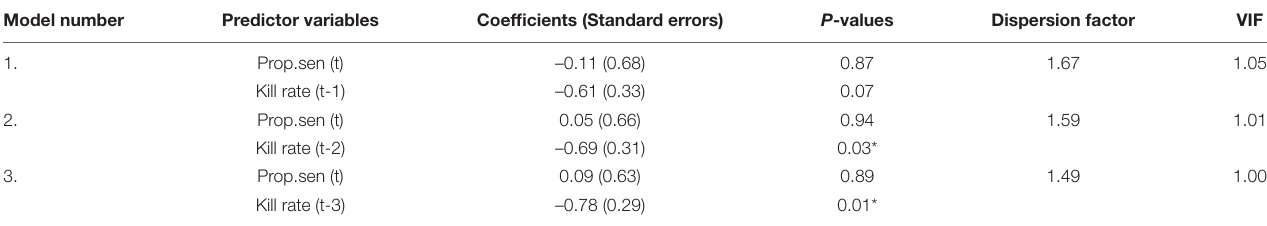
TABLE 1 | Coefficients from bivariate models predicting temporal variation in the incidence of OA among dead moose over a 33-year period (1975–2007) from the proportion of adults in the populations that were senescent (Prop.sen, an indicator of population age structure) and kill rate by wolves (the number of moose killed, per wolf, each year) lagged up to 3